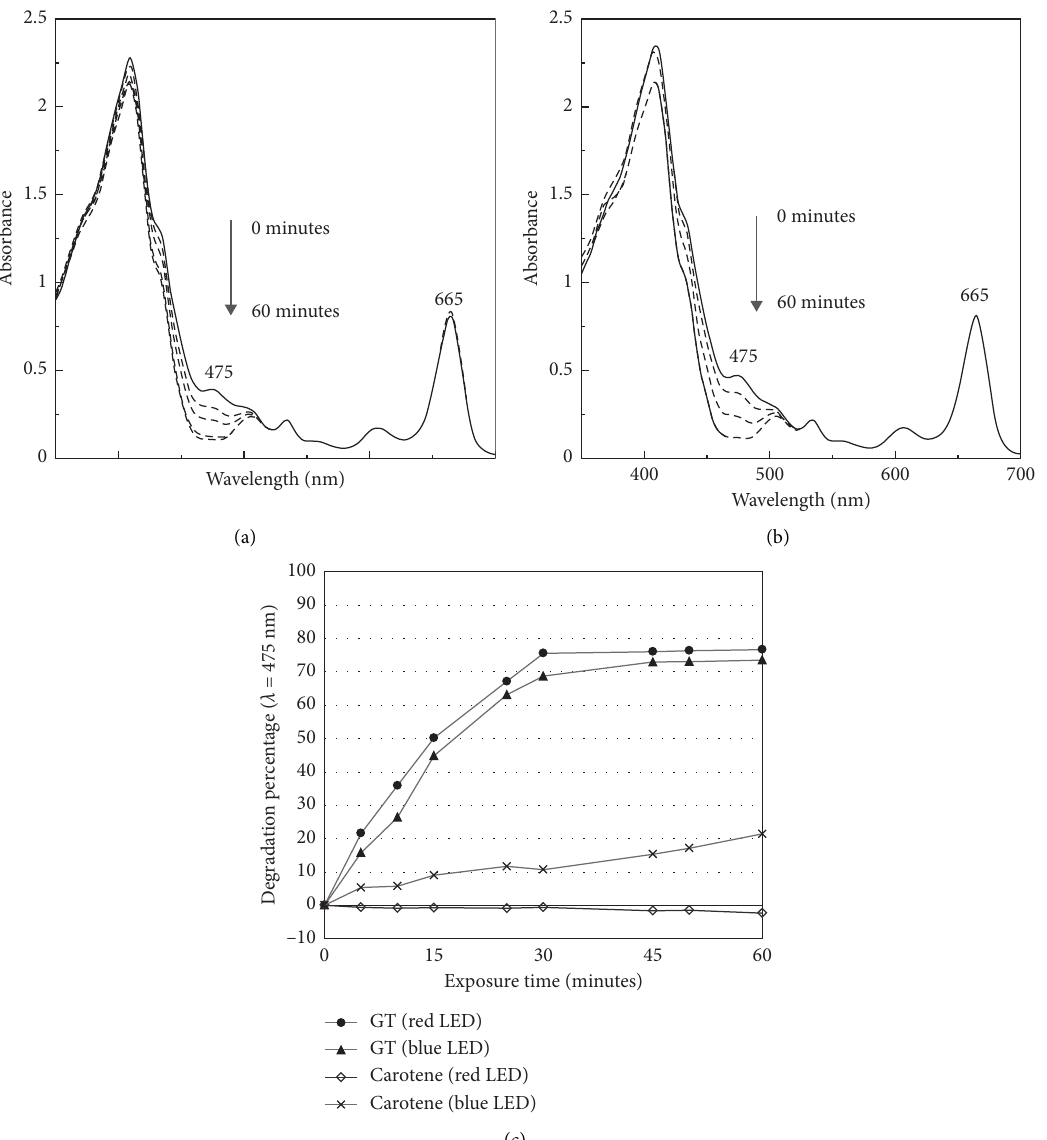
Figure 8: Absorption spectra of pigments recovered from the dregs of green tea (GT) in acetone solvent during irradiation treatment 0–60min using blue (a) and red (b) LEDs. The observed reductions in absorption at 475 nm were plotted and compared to the equivalent treatment for standard carotene